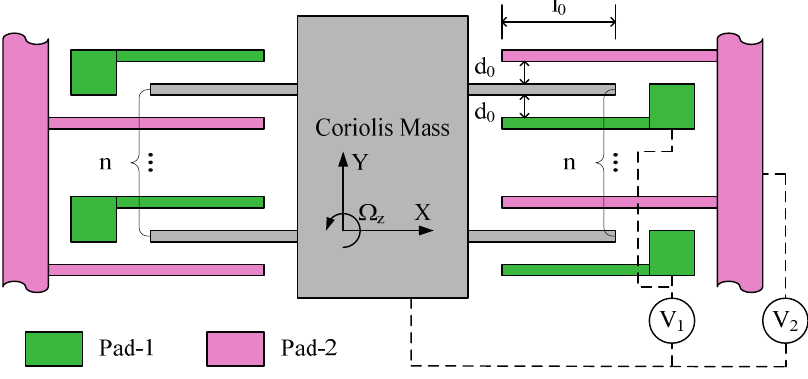
Figure 1. An example of quadrature compensation patterns used in surface silicon